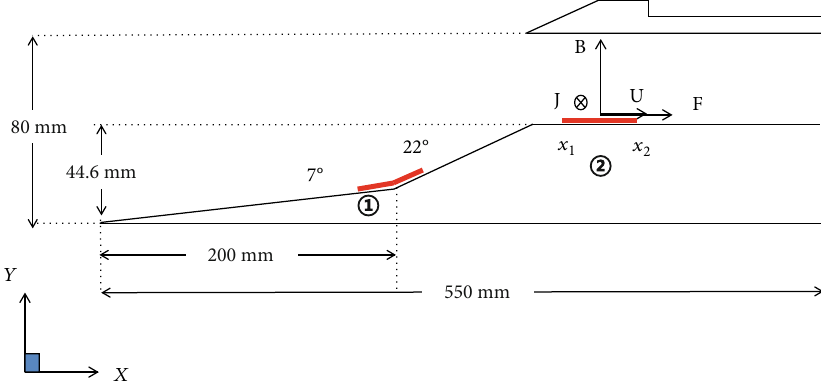
Figure 18: Schematic sketch of MHD separation fl ow control over a hypersonic inlet.